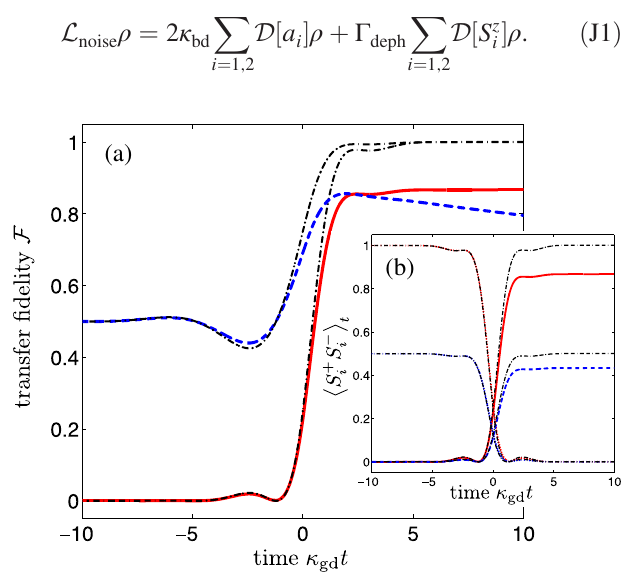
FIG. 15. Numerical simulation of state transfer for two different initial states j 1 i 1 (red solid line) and ðj 0 i 1 − j 1 i 1 Þ = ffiffiffi p 2 (blue dashed line) in the presence of Markovian noise. Black (dash-dotted) curves refer to the ideal, noise-free sce- 0 Þ , where perfect transfer is achieved, while nario ð L noise ¼ colored curves take into account decoherence processes. S − (a) Transfer fidelity F . (b) Excited-state occupation h S þ i i i t for first and second qubit. Numerical parameters are 5% , and Γ 5% . g 1 ð t ≥ 0 Þ ¼ κ = κ = κ , κ gd bd gd ¼ deph gd ¼